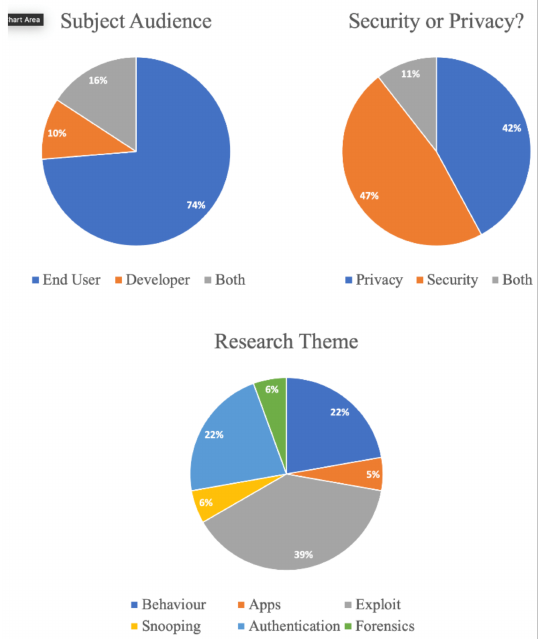
Figure 4. Visual representation of study